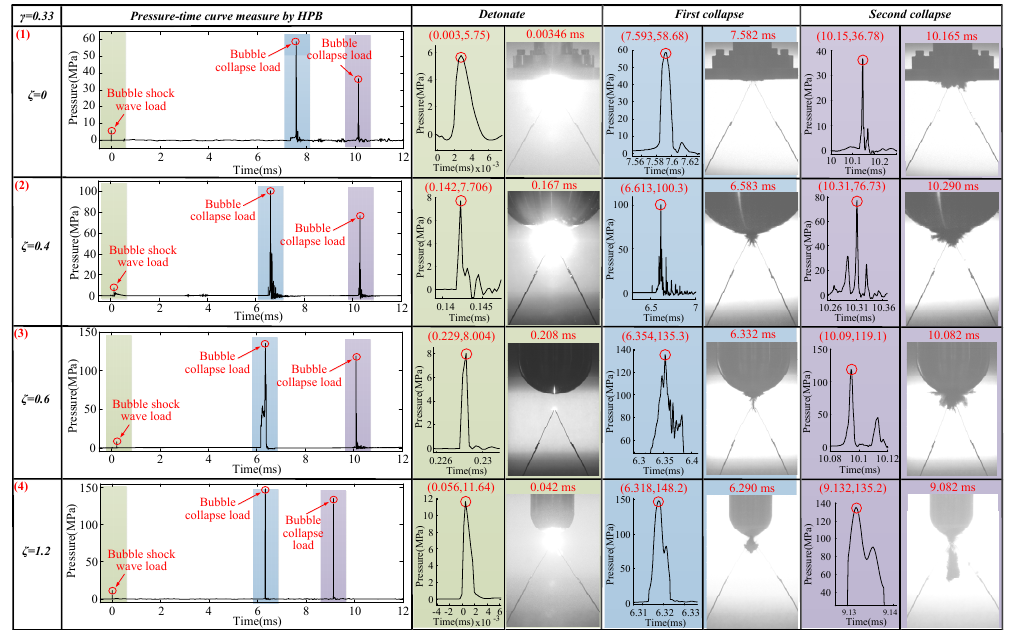
Figure 20. Based on this experimental result, we posit that an obvious upward jet will cause the bubble double peak phenomenon.